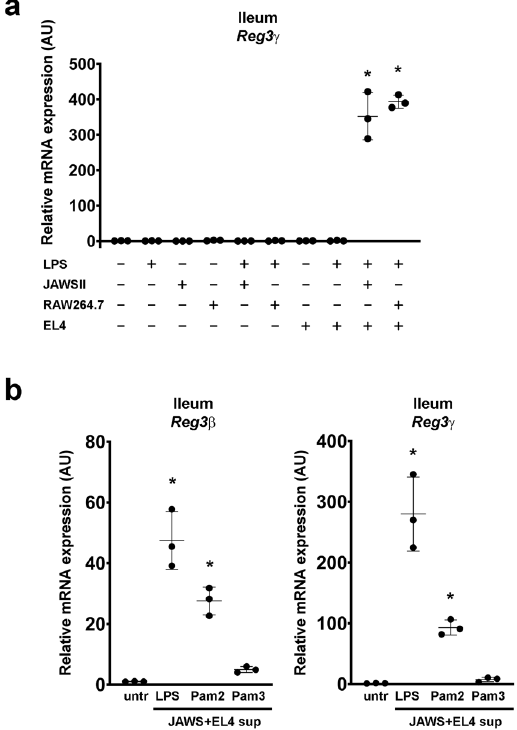
Fig. 1 Reg3 β and Reg3 γ expression in ileum-derived organoids is dependent on LPS-activated RAW264.7 macrophages or JAWSII dendritic cells and EL4 T cells. a RAW264.7 cells and JAWSII cells stimulated with LPS (1 µ g/ml) for 24 h and subsequently, supernatants were fi rst incubated with EL4 T cells for 24 h and then added to organoids or they were added to organoids directly. Reg3 γ mRNA was determined by QPCR and normalized to untreated organoids. b JAWSII cells stimulated with either LPS, Pam2, or Pam3 (1 µ g/ml) for 24h and subsequently, supernatants were fi rst incubated with EL4 T cells for 24 h and then added to organoids. Reg3 β and Reg3 γ mRNA was determined by QPCR and normalized to untreated organoids. All experiments were performed in triplicate with a minimum of three independent experiments. Data are shown as mean ± SD. For statistical analyses, Log2 transformed data were used in Welch and Brown – Forsythe tests followed by Dunnett ’ s T3 multiple comparisons test. * P < 0.05 was considered to indicate statistical signi fi